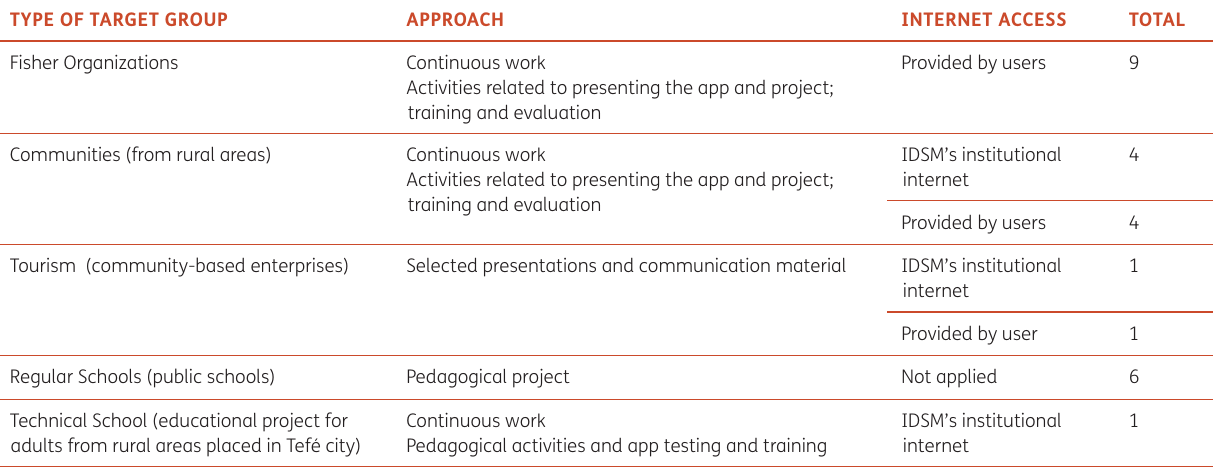
Table 1 Groups involved in the pilot initiative, their characteristics, and the approaches we took with each . Note : IDSM: Mamirauá Institute for Sustainable